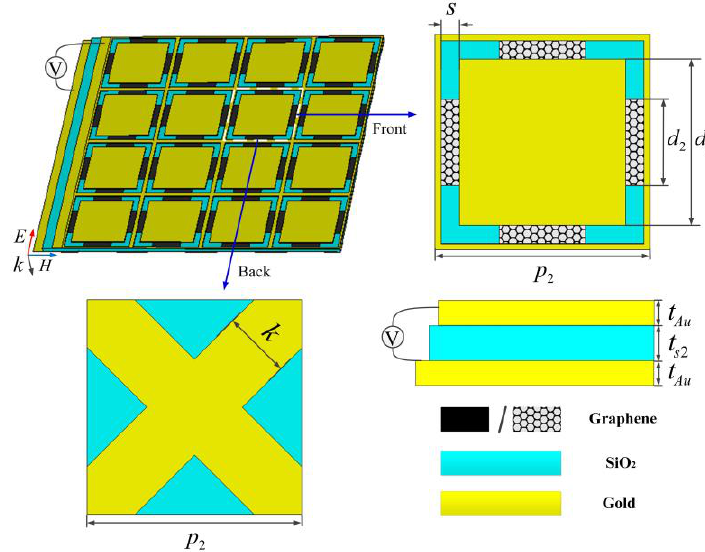
Figure 3. Schematic of the narrowband frequency-tunable absorber. The values of the dimension parameters: p 2 = 35, d 1 = 27, d 2 = 14, s = 3, k = 11, t Au = 0.5, t s2 = 2, unit: μm.